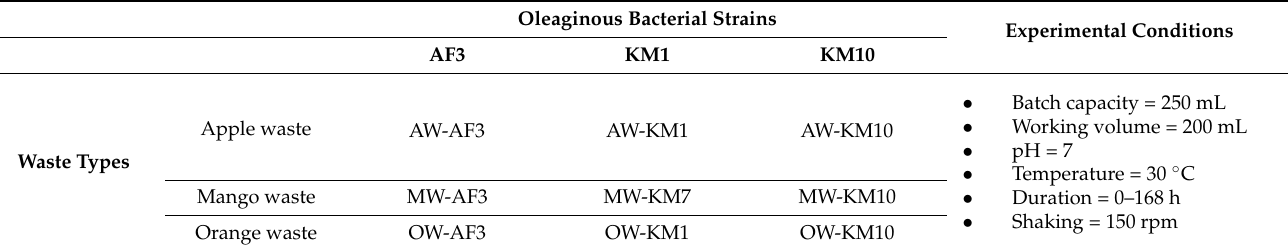
Table 1. Experimental Layout and